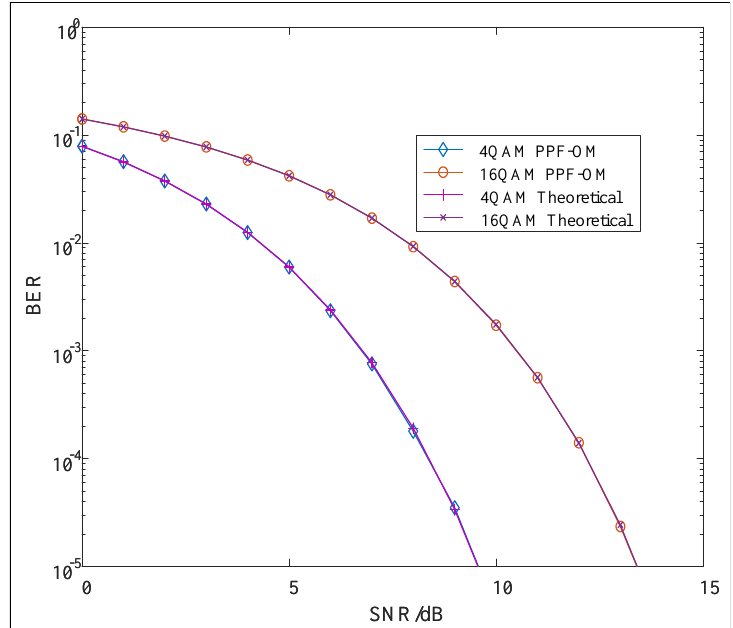
Figure 6. BER performance of PPF-OM